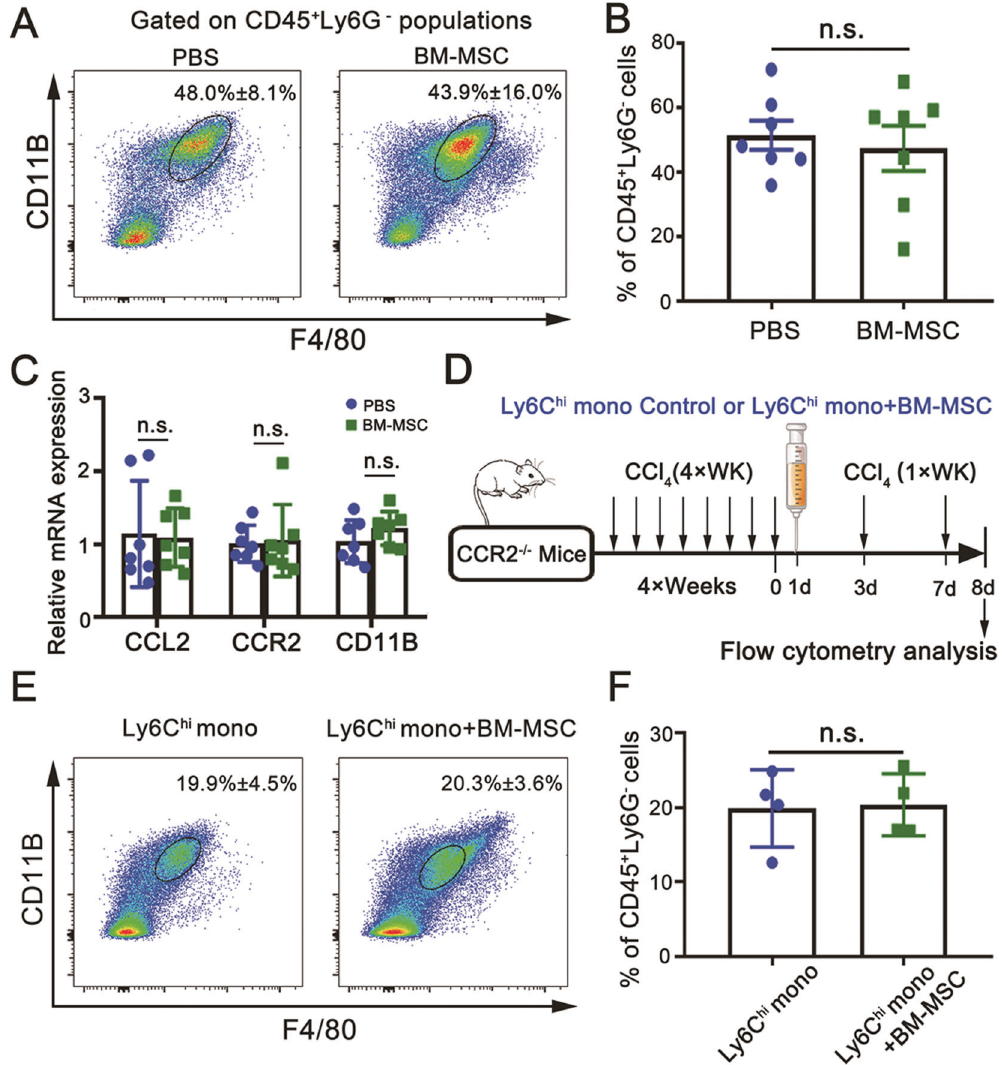
Fig. 3 Evaluation of the effect of BM-MSCs on Ly6C hi monocyte recruitment. A , B Examination of the proportion of CD11B hi F4/80 int macrophages in livers at 24 h post- fi nal CCl 4 injection by FCM analysis ( n = 7). CCl 4 -induced fi brotic mice were infused with 1 × 10 6 BM-MSCs or PBS (control) at 24 h post-8 th CCl 4 injection, and mice were continually injected with CCl 4 for another week. C Quantitative real-time PCR analysis for the transcriptional expression levels of genes related to chemotaxis ( n = 7). D Schematic of the working model for in vivo adoptive transfer assay by using a CCR2 − / − mouse. The CCR2 − / − mice were i.v. injected with CCl 4 (1 mg/kg) twice a week for 4 weeks. Thereafter, 5 × 10 5 Ly6C hi monocytes were transferred into CCR2 − / − fi brotic mice with or without equivalent BM-MSCs at 24 h post- fi nal CCl 4 injection. FCM analysis was performed at 7 days after adoptive transfer. Ly6C hi mono is the abbreviation of Ly6C hi monocytes. E , F Examination of the proportion of intrahepatic CD11B hi F4/80 int macrophages from different transfer groups by FCM analysis ( n = 4). Bars = means ± SD. Statistical evaluation of two groups was performed using independent Student t -test; n.s. p >